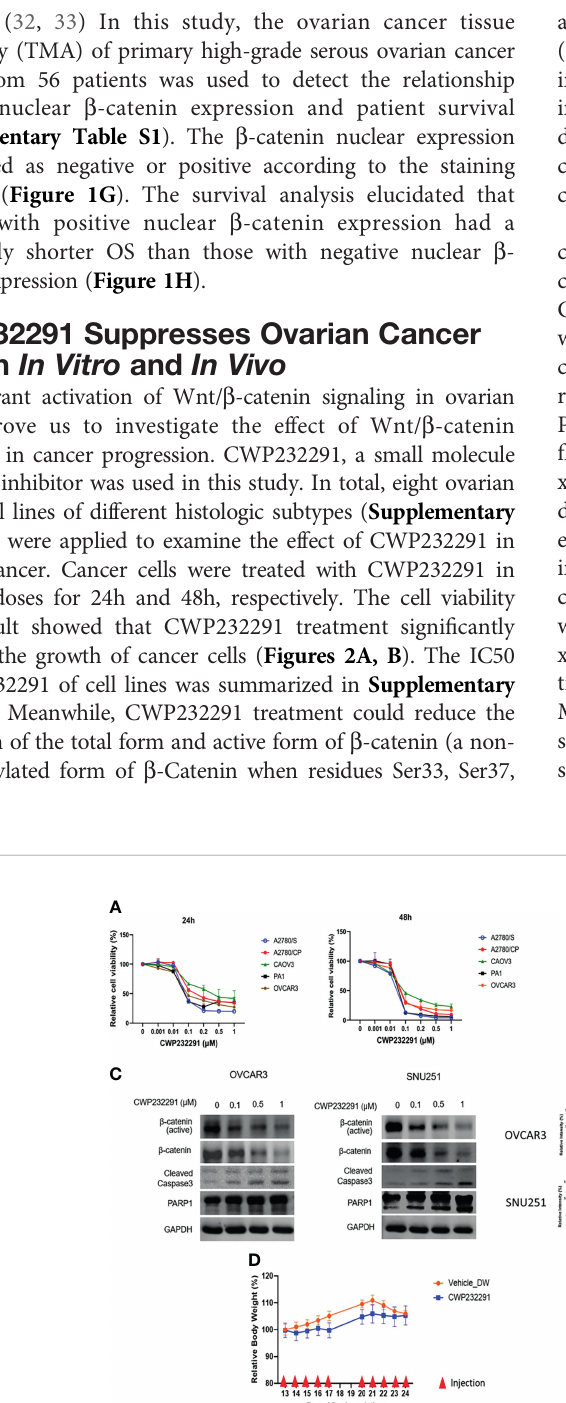
FIGURE 2 | CWP232291 suppressed the growth of various ovarian cancer cell lines through b -catenin inhibition. Five ATCC cell lines, A2780/S, A2780/CP, CAOV3, PA1 and OVCAR3 (A) and three SNU cell lines, SNU119, SNU251, SNU840 (B) were used in this study. Cells were treated with different doses (0, 0.001, 0.01, 0.1, 0.2, 0.5, 1.0 µM) of CWP232291 for 24h and 48h. Cell viability was measured through MTT assay. (C) The representative ATCC cell line OVCAR3 and SNU cell line SNU251 were treated with different doses of CWP232291 (0, 0.1, 0.5, 1µM) for 24h and the expression of active b -catenin form, total b -catenin form and apoptotic markers was determined by Western blotting. CWP232291 inhibited tumor growth in the in vivo mouse model. (D) The tumor size was measured and calculated using the formula: 0.5×length × (width) 2 . (E) The body weight of mice was also examined together with the tumor size. Results were shown as mean ± SEM (*p ≤ 0.05, **p ≤ 0.01, ***p ≤